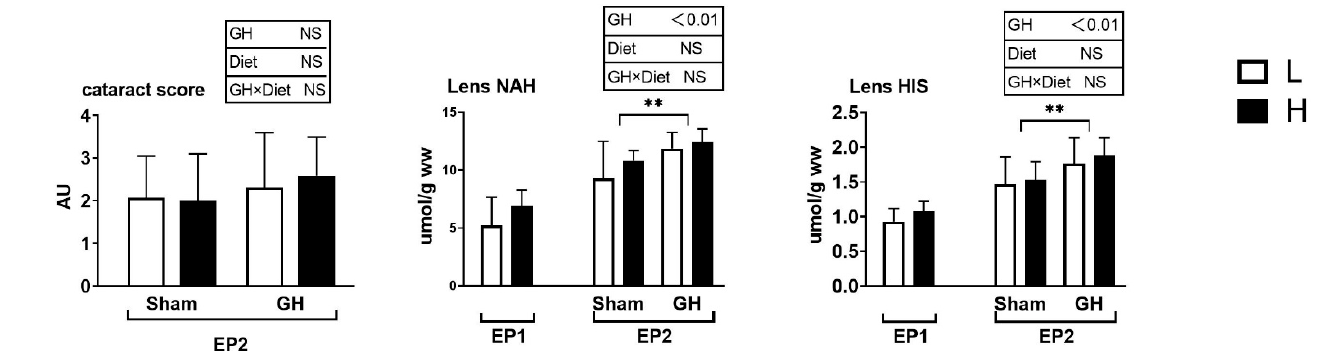
Figure 3. Cataract score, lens histidine, and lens N-acetyl L-histidine (NAH) in Atlantic salmon. Cataract score was only detected in the EP2. Data presented as means ± SD. p -values obtained from two-way ANOVA on the main effects of diet, GH, and interaction are provided in insets. **; significant effect of treatment ( p < 0.01, two-way ANOVA).